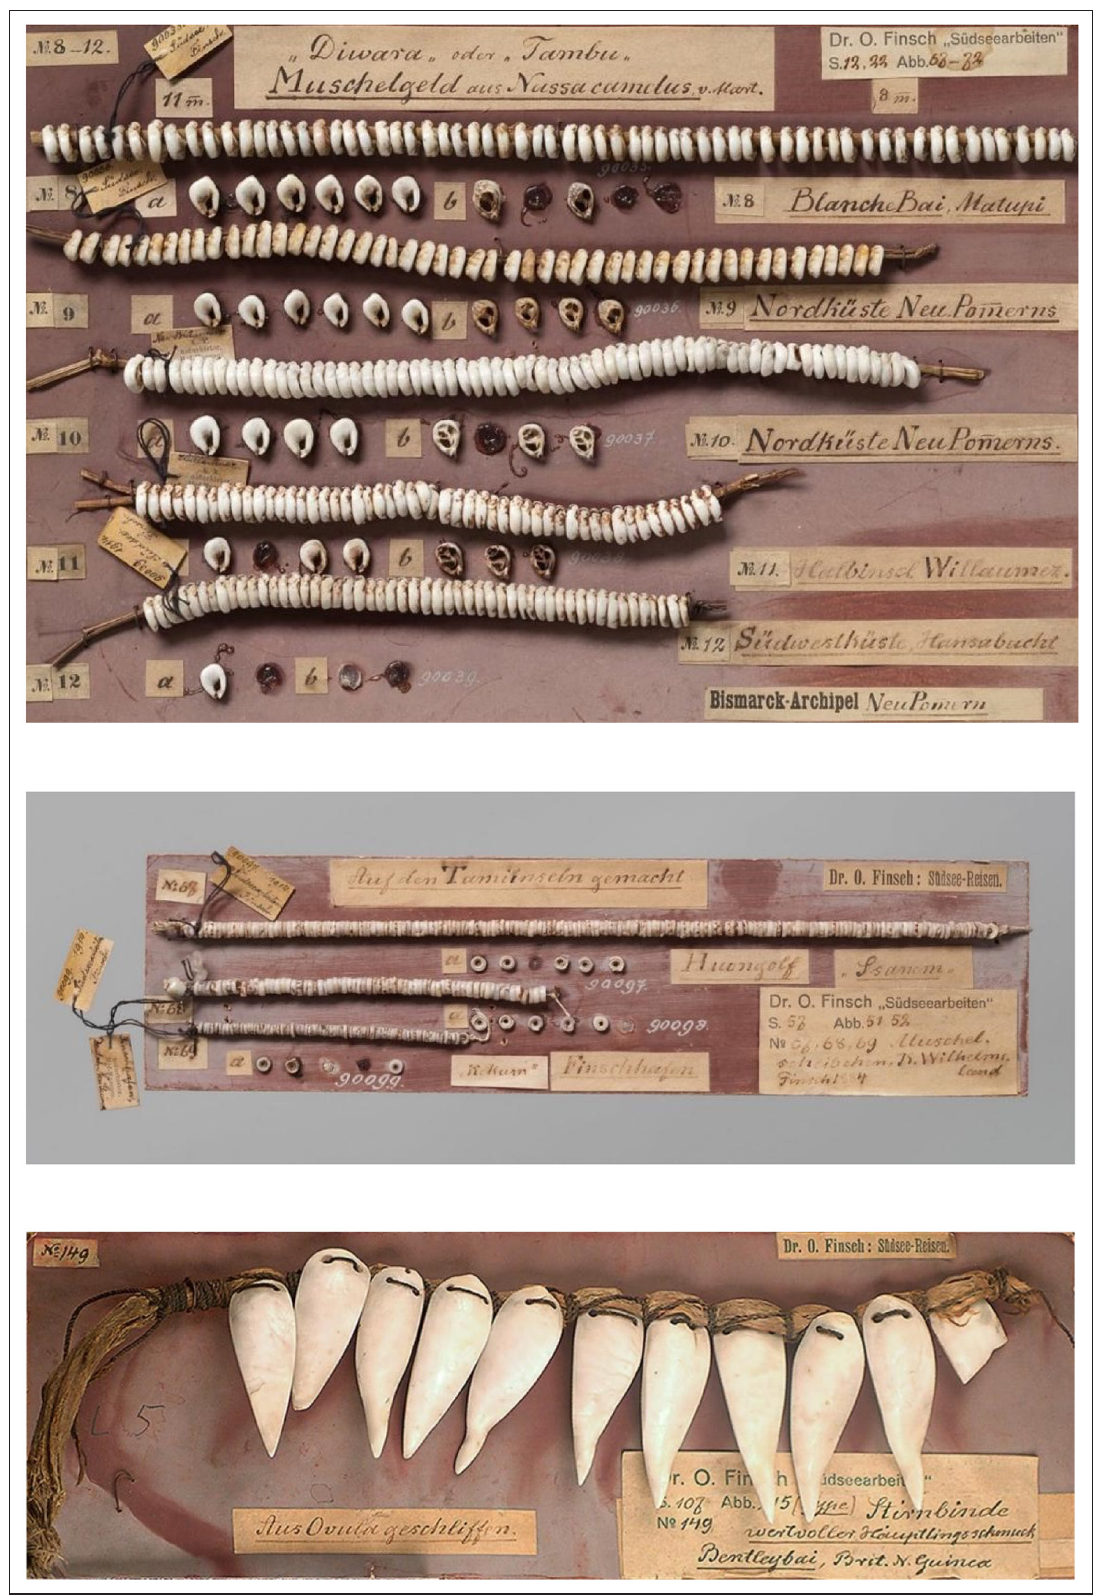
Figure 4: Various examples of shell money and jewelry from German New Guinea. The labels show intensive classification and correspond to Finsch, Südseearbeiten , 1914. Collection Otto Finsch, Weltmuseum Wien/ Austria (Nos. 8–12, 68, 69,